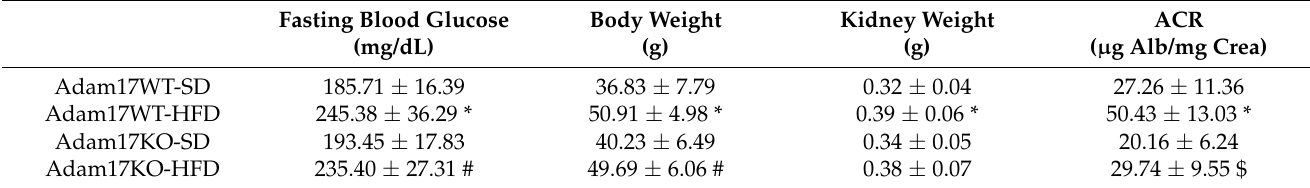
Table 1. Fasting blood glucose, body weight, kidney weight, and urinary albumin excretion were measured after 22 weeks of follow-up ( n = 8). Values are expressed as mean ± SD. Abbreviations: SD, standard diet; HFD, high fat diet; Adam17WT, wild-type; Adam17KO, knockout. * p <